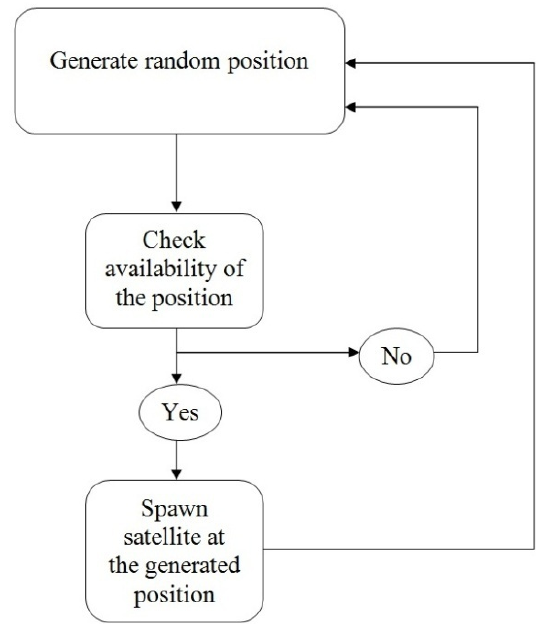
Figure 2. UML-like presentation of the basic logic behind the spawning algorithm.